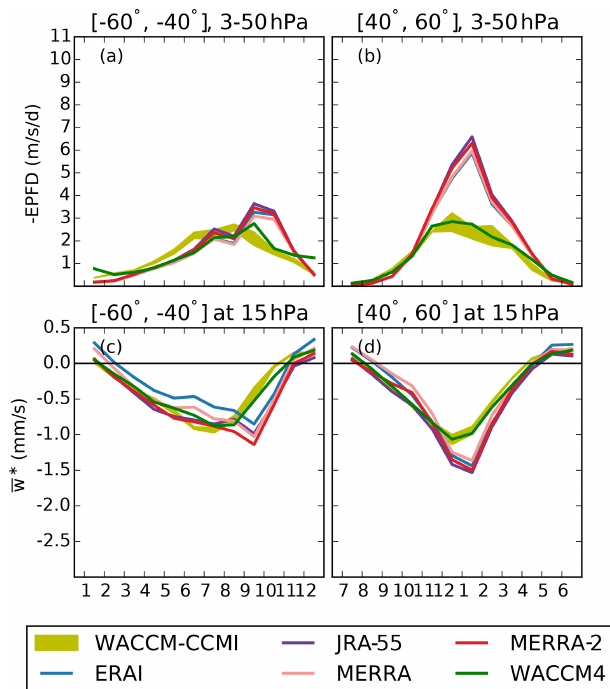
Figure 7. As for Fig. 5 but for the middle latitudes: (a, c) southern midlatitudes (40–60 ◦ S); (b, d) northern midlatitudes (40–60 ◦ N).